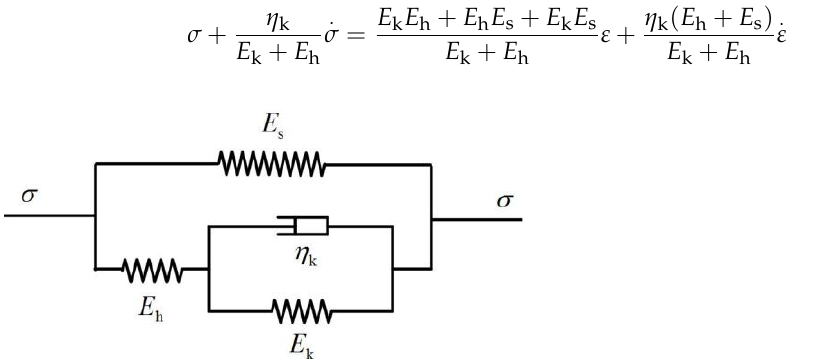
Figure 2. General Kelvin and spring element parallel coupled creep